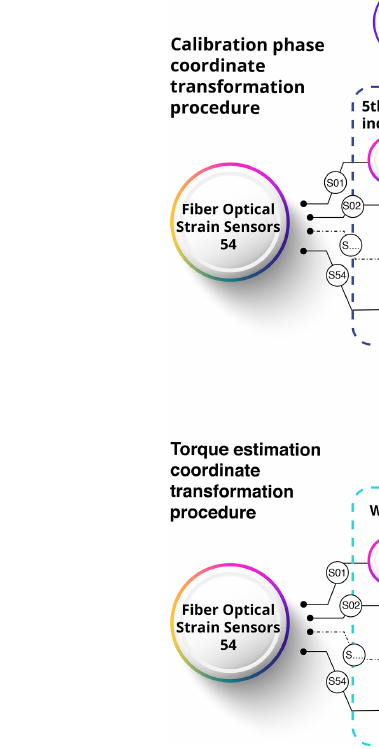
(higher instantaneous K γ values), the torque variations would be